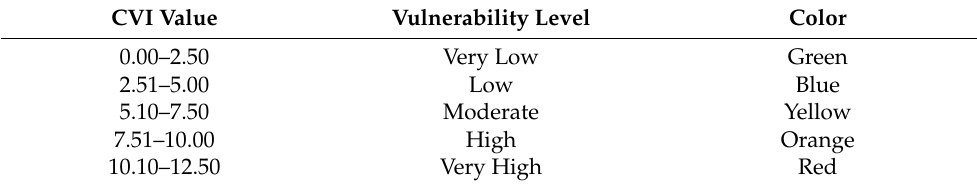
Table 3. Classification of vulnerability levels.